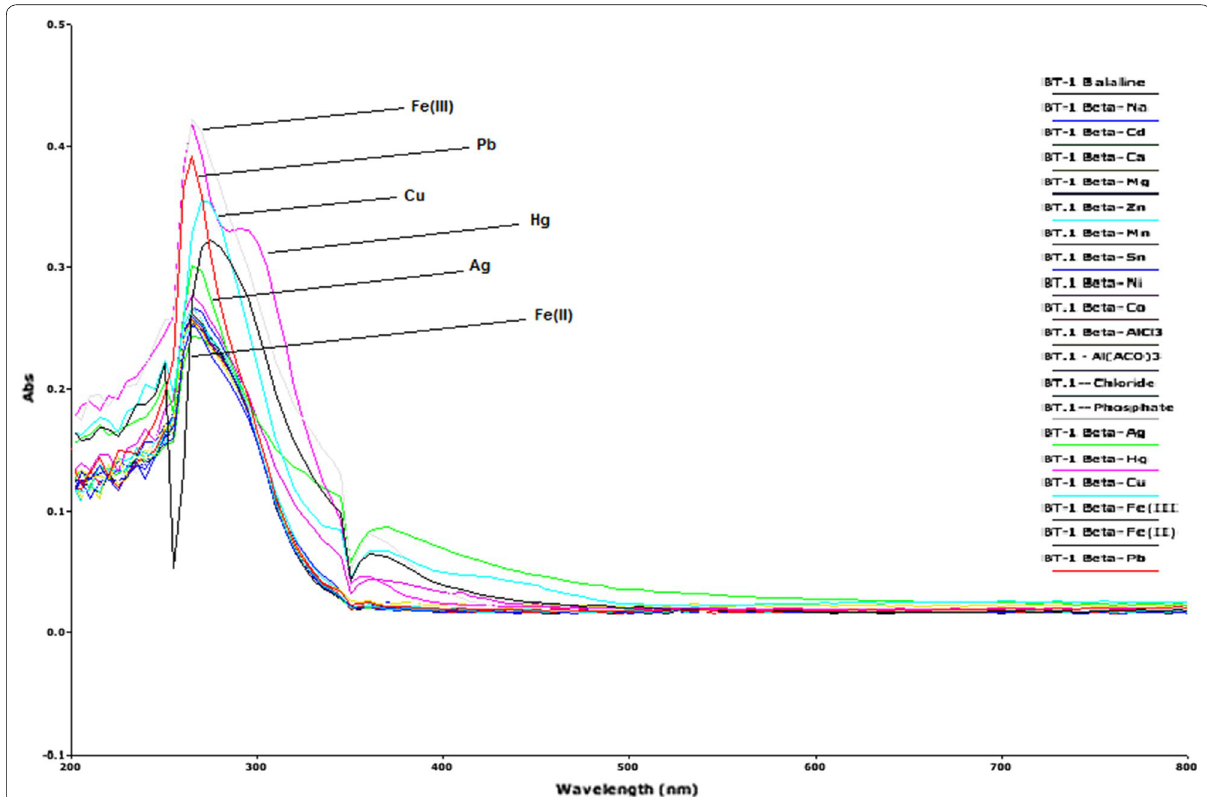
Fig. 5 Interactions of isomer 1B with various metal ions and tetrabutylammonium